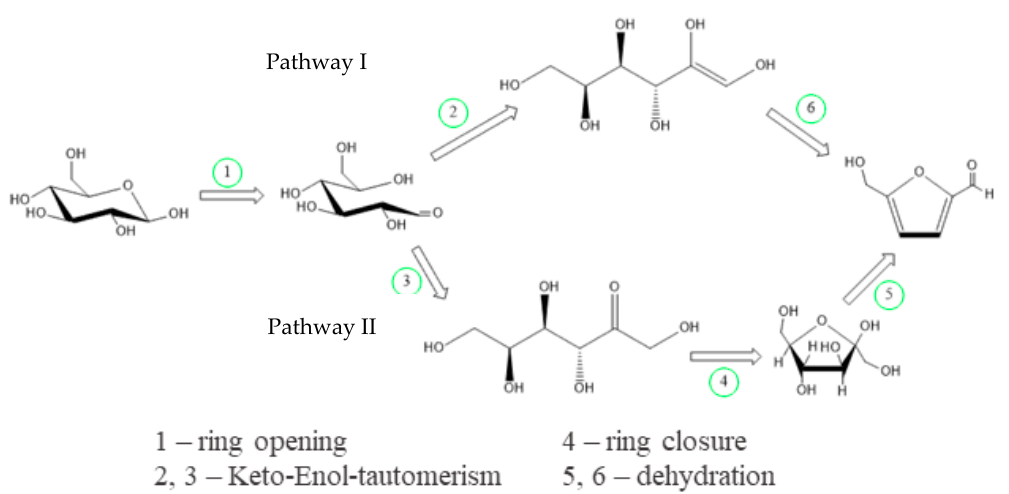
Figure 6. Isomerization of glucose to fructose and subsequent dehydration to form HMF; modified from Ji et al. [62].